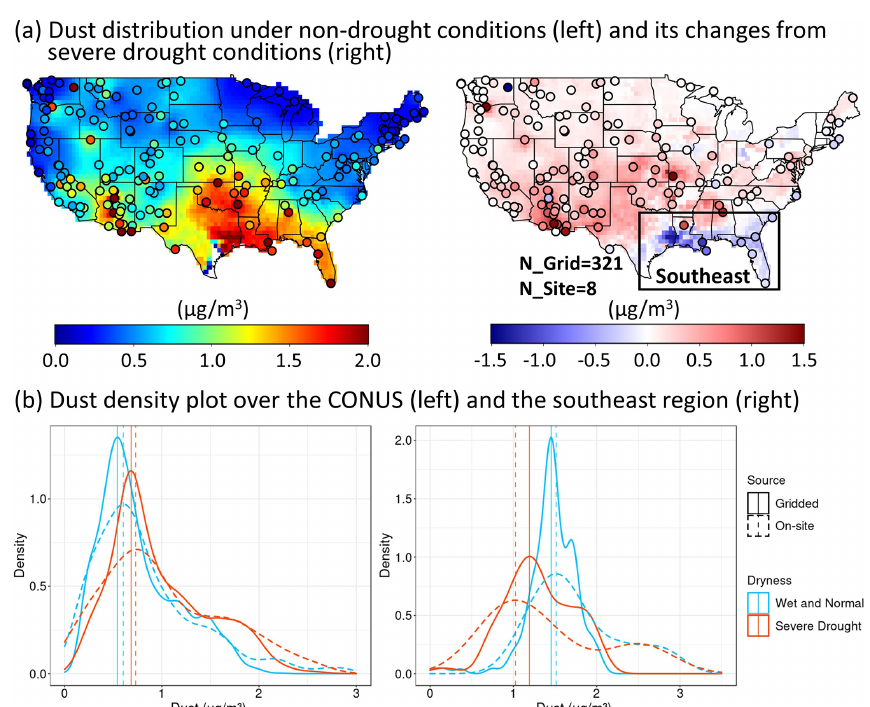
Figure 1. (a) Maps of the mean gridded and in situ (dots) fine dust under USDM-based non-drought (wet and normal) conditions (left) from 2000 to 2019 in JJA and its changes from severe-drought conditions (right). The number of grids and sites within the southeast region is denoted by N_Grid and N_Site, respectively. (b) Comparisons of density distributions of gridded (solid lines) and in situ (dashed lines) fine-dust concentrations during 2000–2019 JJA under drought (red lines) and non-drought (blue lines) conditions over the CONUS (left) and southeast region (right). Vertical dashed and solid lines indicate the modes.